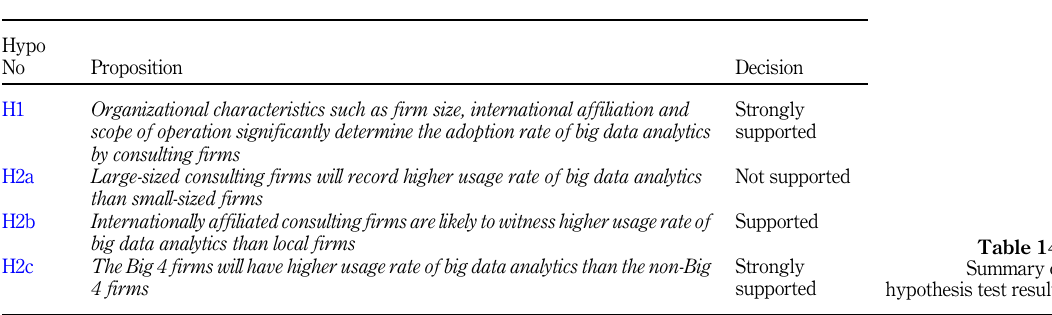
Table 13. Overall level of use of